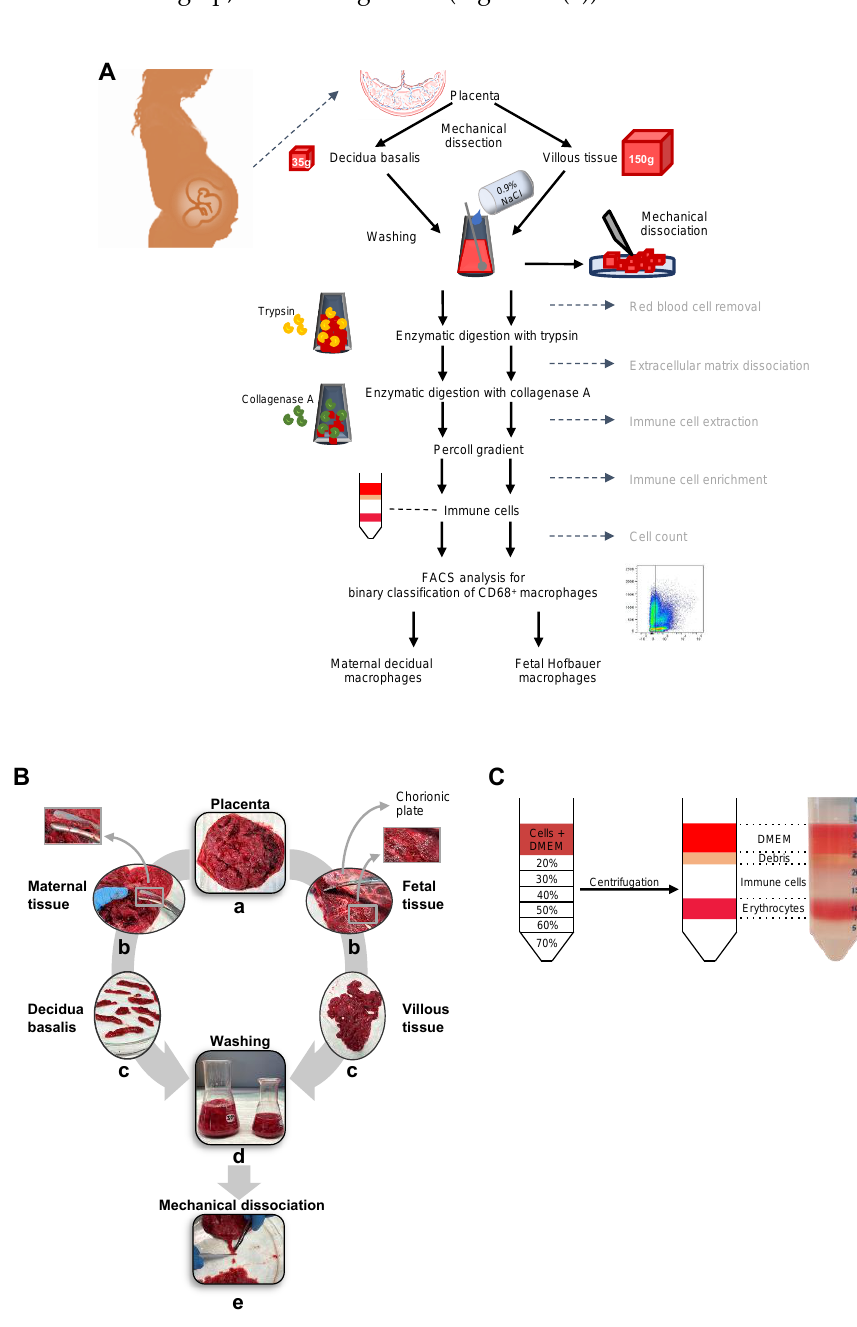
Figure 4. ( A ) Graphical abstract of the isolation protocol. ( B ) Mechanical dissection of the placenta: a, Whole placenta, b, dissection of decidua basalis and VT with enlarged details, c, dissected decidual and VT, d, washing, and e, mechanical dissociation. ( C ) Percoll-layer before centrifugation and the separated layers after